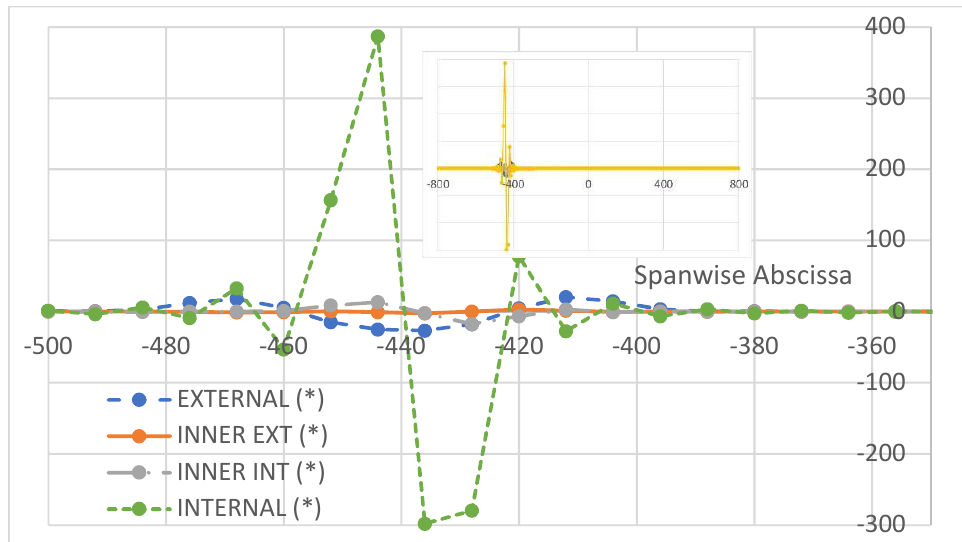
Figure 30. Strain difference between the signal taken by the optical fiber for a certain position of the flaw, and the deformation resulting when the imperfection is placed at the middle of the cap. Focus in the region of the damage. In the small picture embedded, there is an enlarged image of this referenced signal. Values are referenced to those recorded in the case of a flaw placed at the middle of the cap (*).